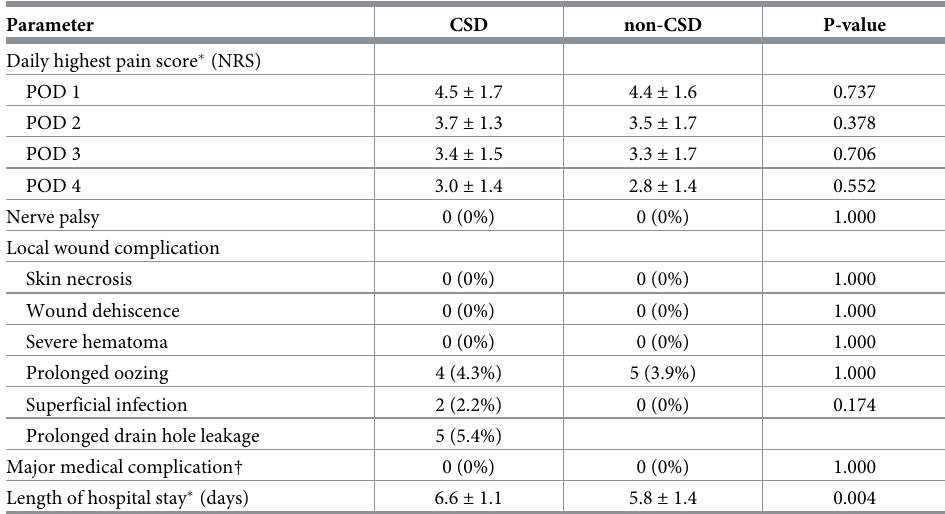
Table 3. Early postoperative pain scales and